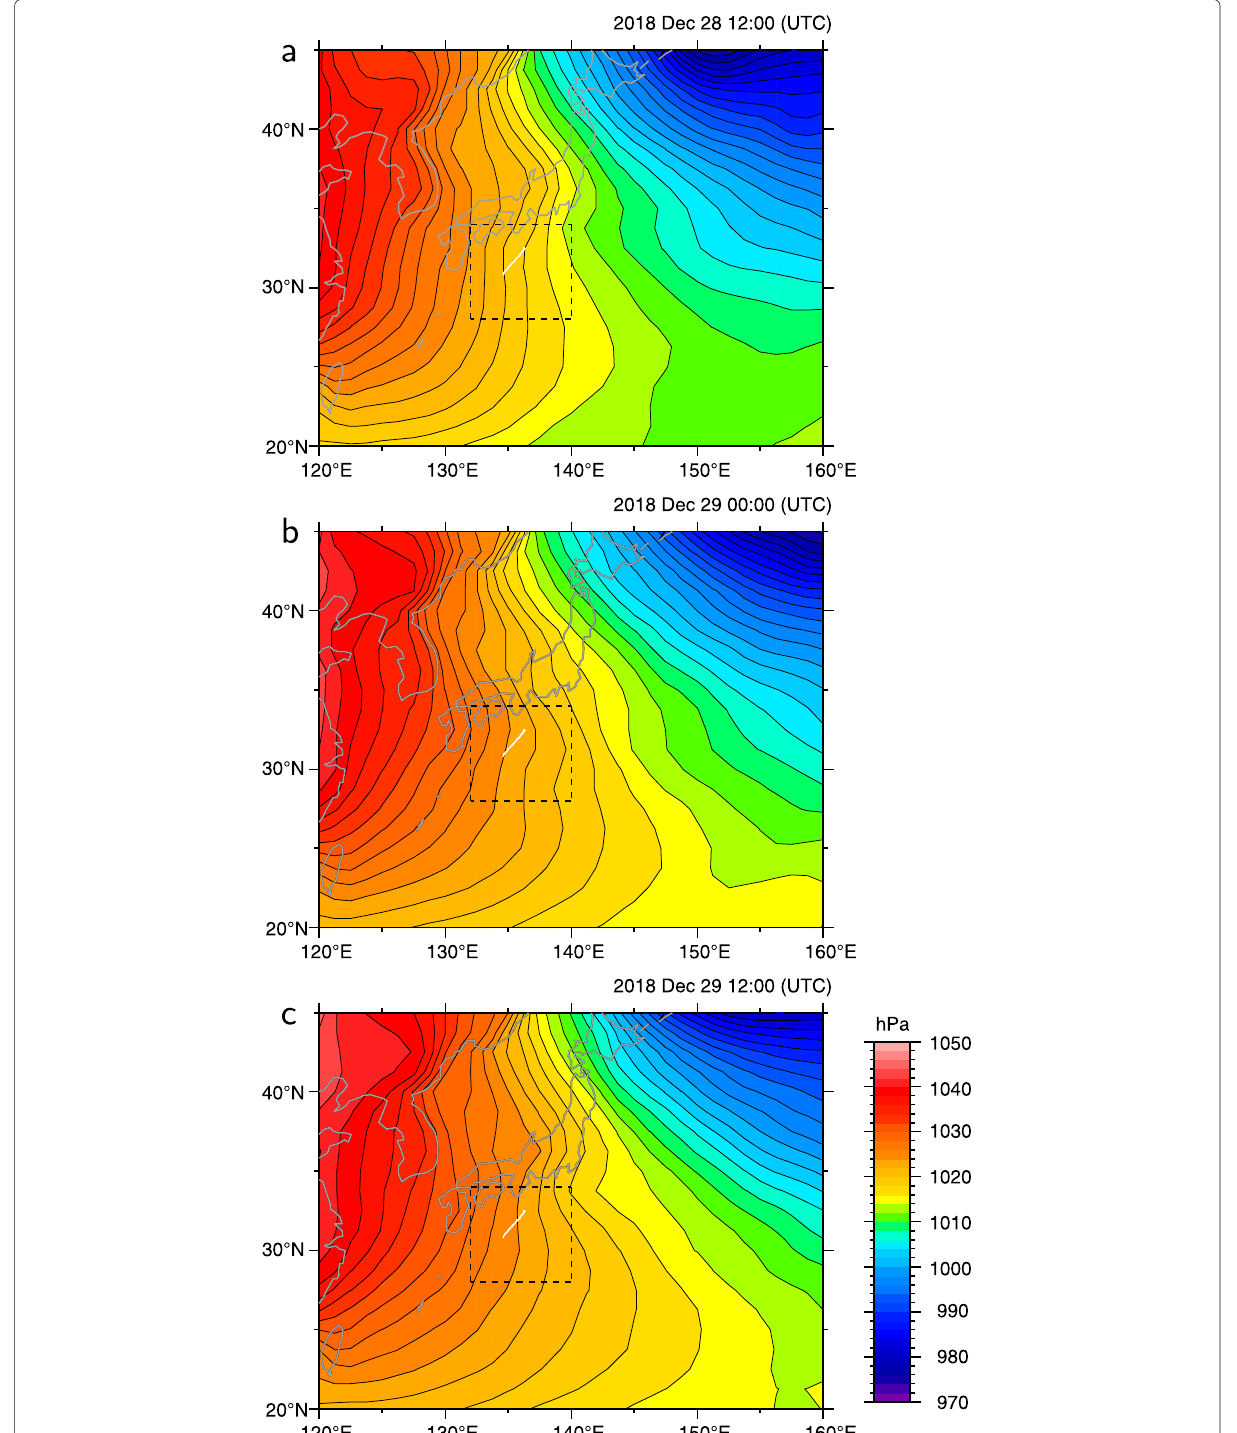
Fig. 5 Variation in sea level pressure (SLP) in hPa while the Saildrone crossing the A track. Maps of SLP are shown every 12h from a December 28 12:00, 2018, to c December 29 12:00, 2018 (UTC). Data are based on JRA-55 (Kobayashi et al. 2015) and contour intervals are 2hPa. The study region is the region enclosed by the dashed line square and track A is indicated by white